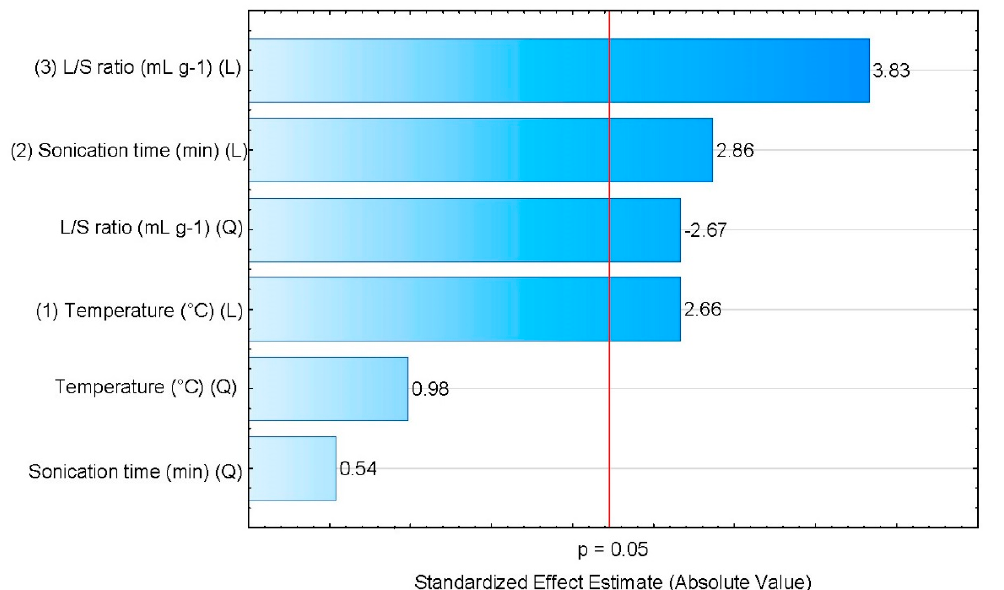
Table 5. Analysis of variance (ANOVA) for SCG oil extraction.